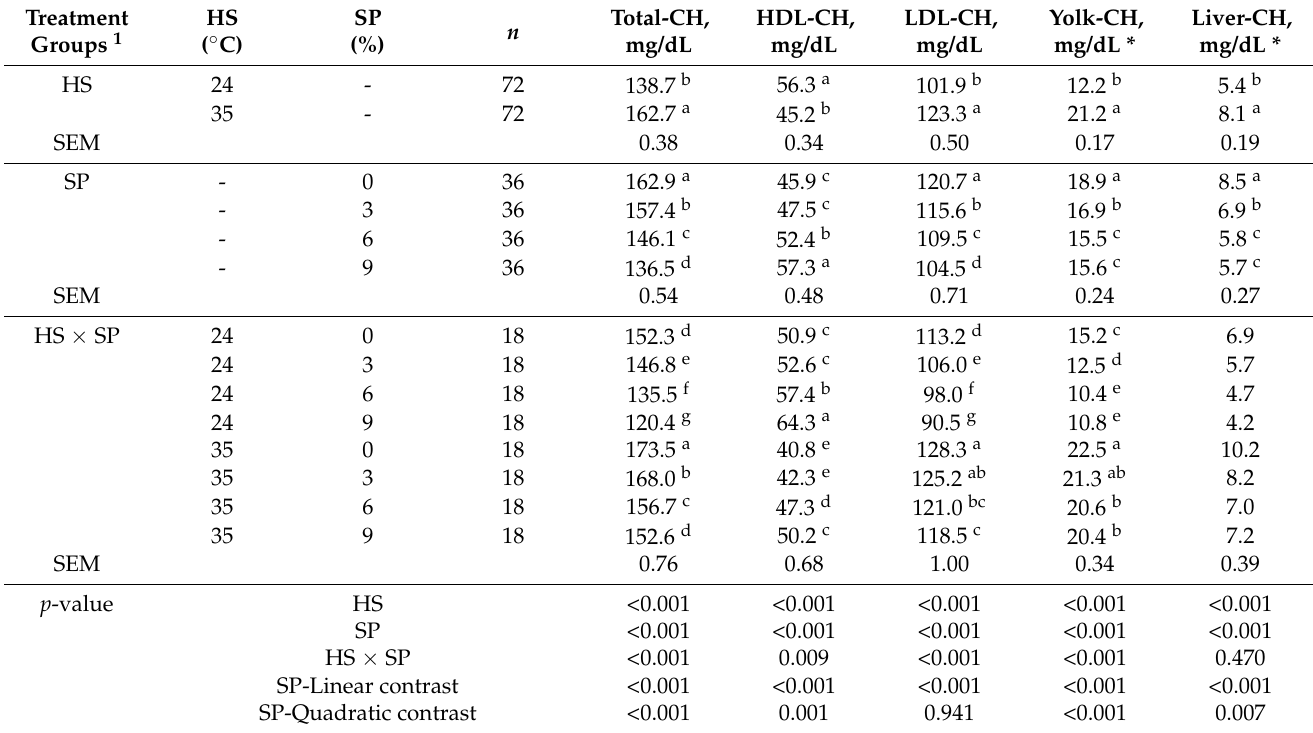
Table 3. Effect of dietary Spirulina platensisis (SP) supplementation on the cholesterol profile of laying hens exposed to cyclic heat stress (HS).